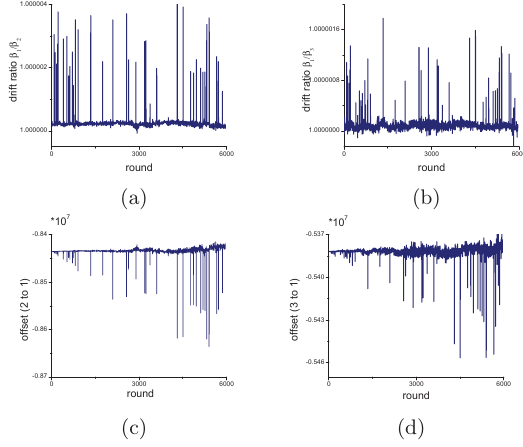
Figure 6: Relative Clock Drift and Offset